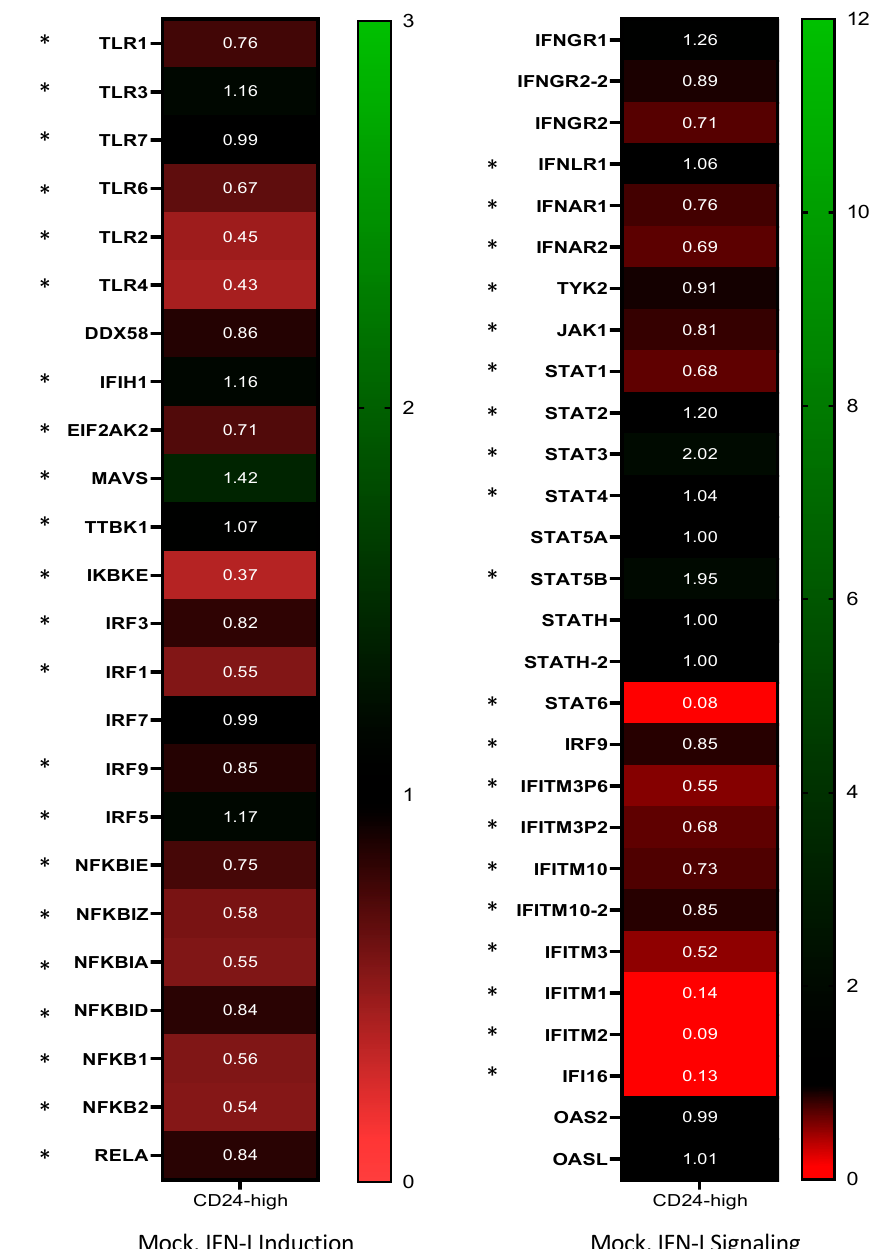
Mock, IFN-I Induction Mock, IFN-I Signaling Figure 8. Global transcriptomic analysis reveals downregulation of key IFN-I pathway genes in CD24-high versus CD24-low cells. In the absence of virus, cultures of CD24-low and -high cells were mock-infected, and total cellular RNA was isolated and analyzed by RNA sequencing as described in the Materials and Methods. Using CD24-low cells as a baseline, heat maps were generated to visualize fold changes in IFN induction and IFN-signaling pathway genes that were either upregulated (green, values > 1) or downregulated (red, values < 1) in mock-infected CD24-high cells. Genes labelled with * indicate a p -value less than 0.05. Values are the mean of three samples.